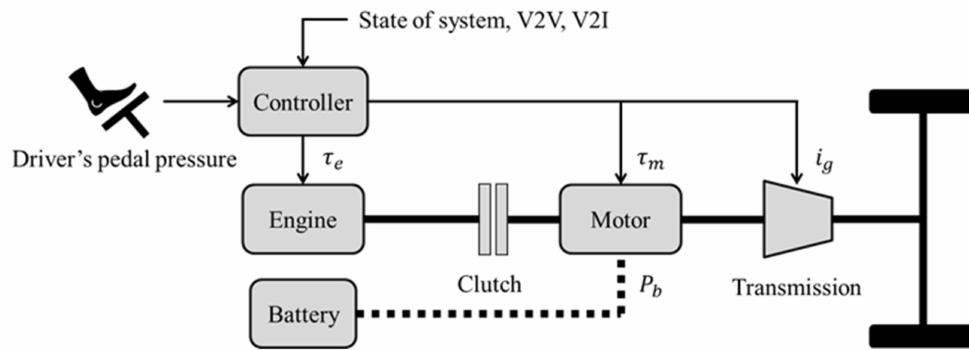
Figure 1. Structure of HEV